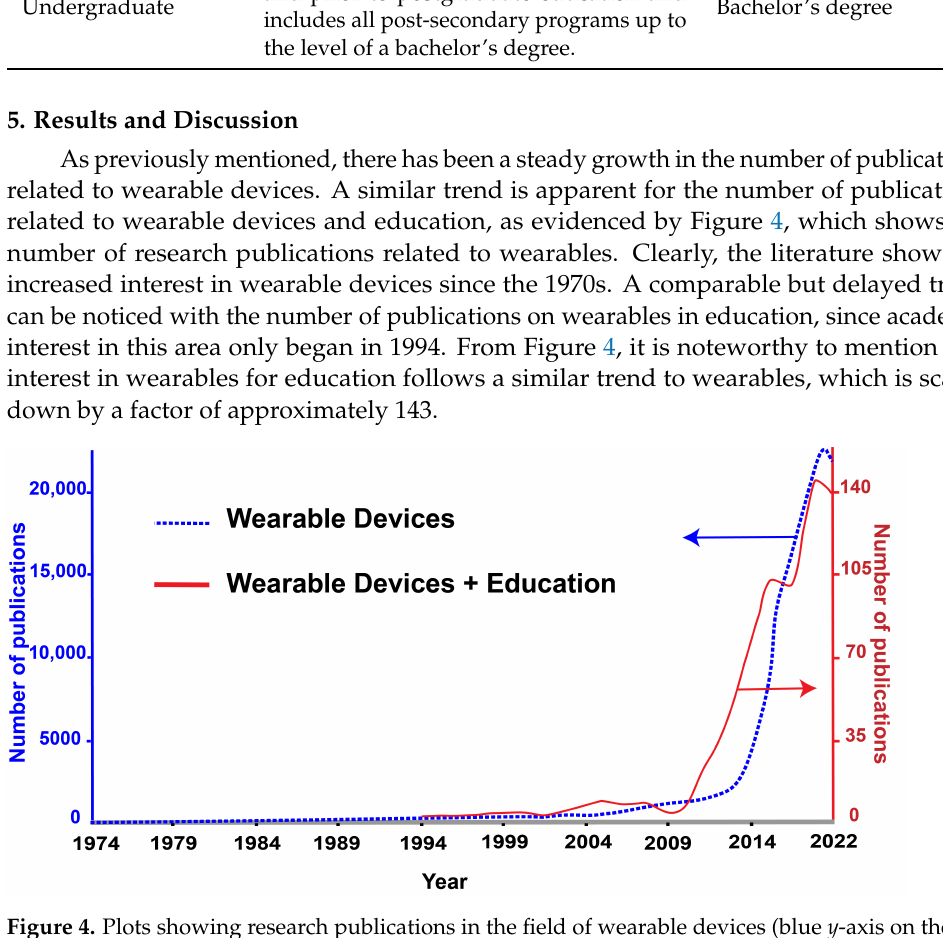
Figure 4. Plots showing research publications in the field of wearable devices (blue y -axis on the left side), and wearable in education (red y -axis on right side) since 1974. The data were extracted